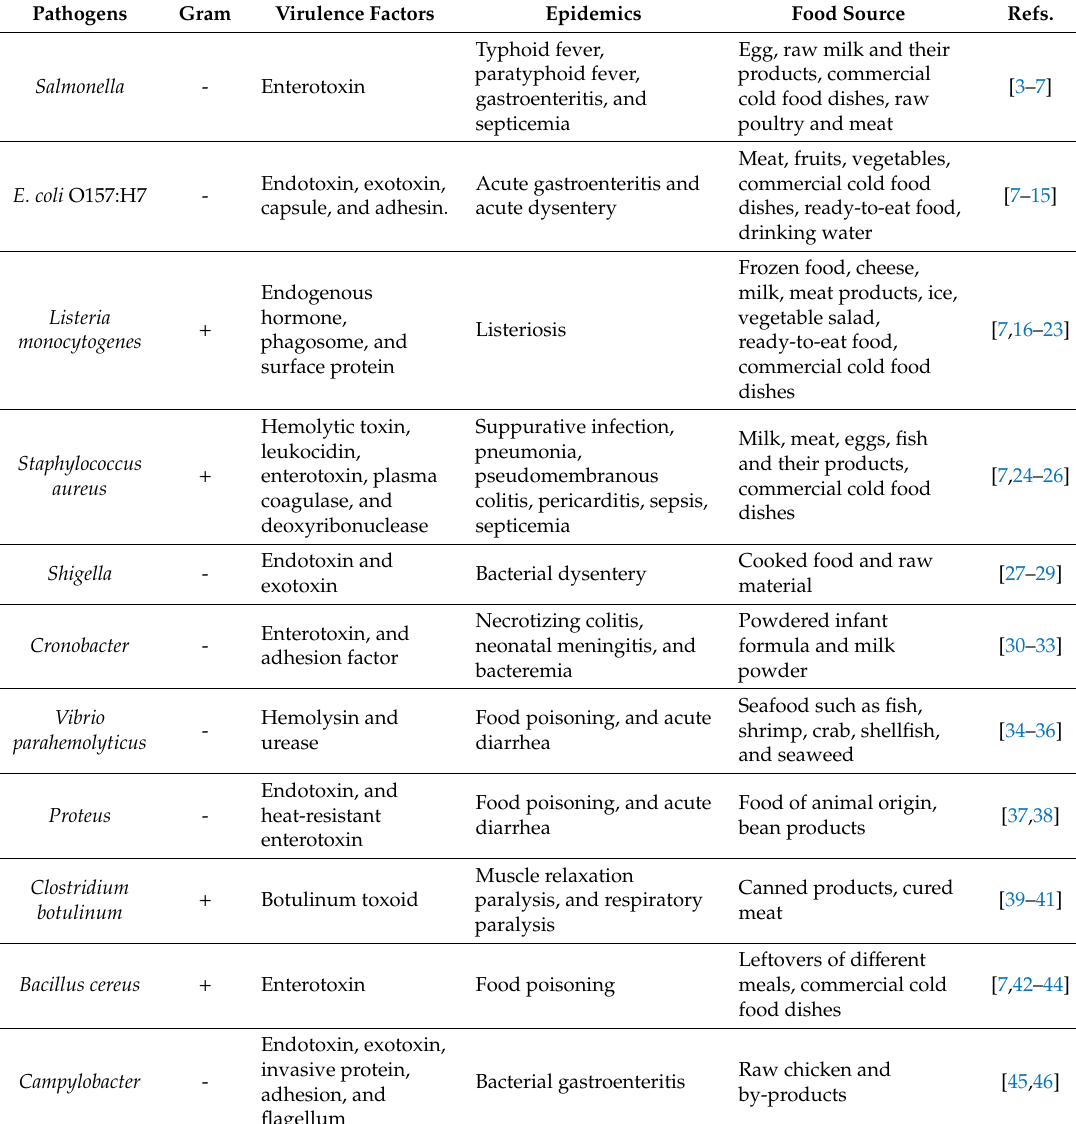
Table 1. Common food-borne